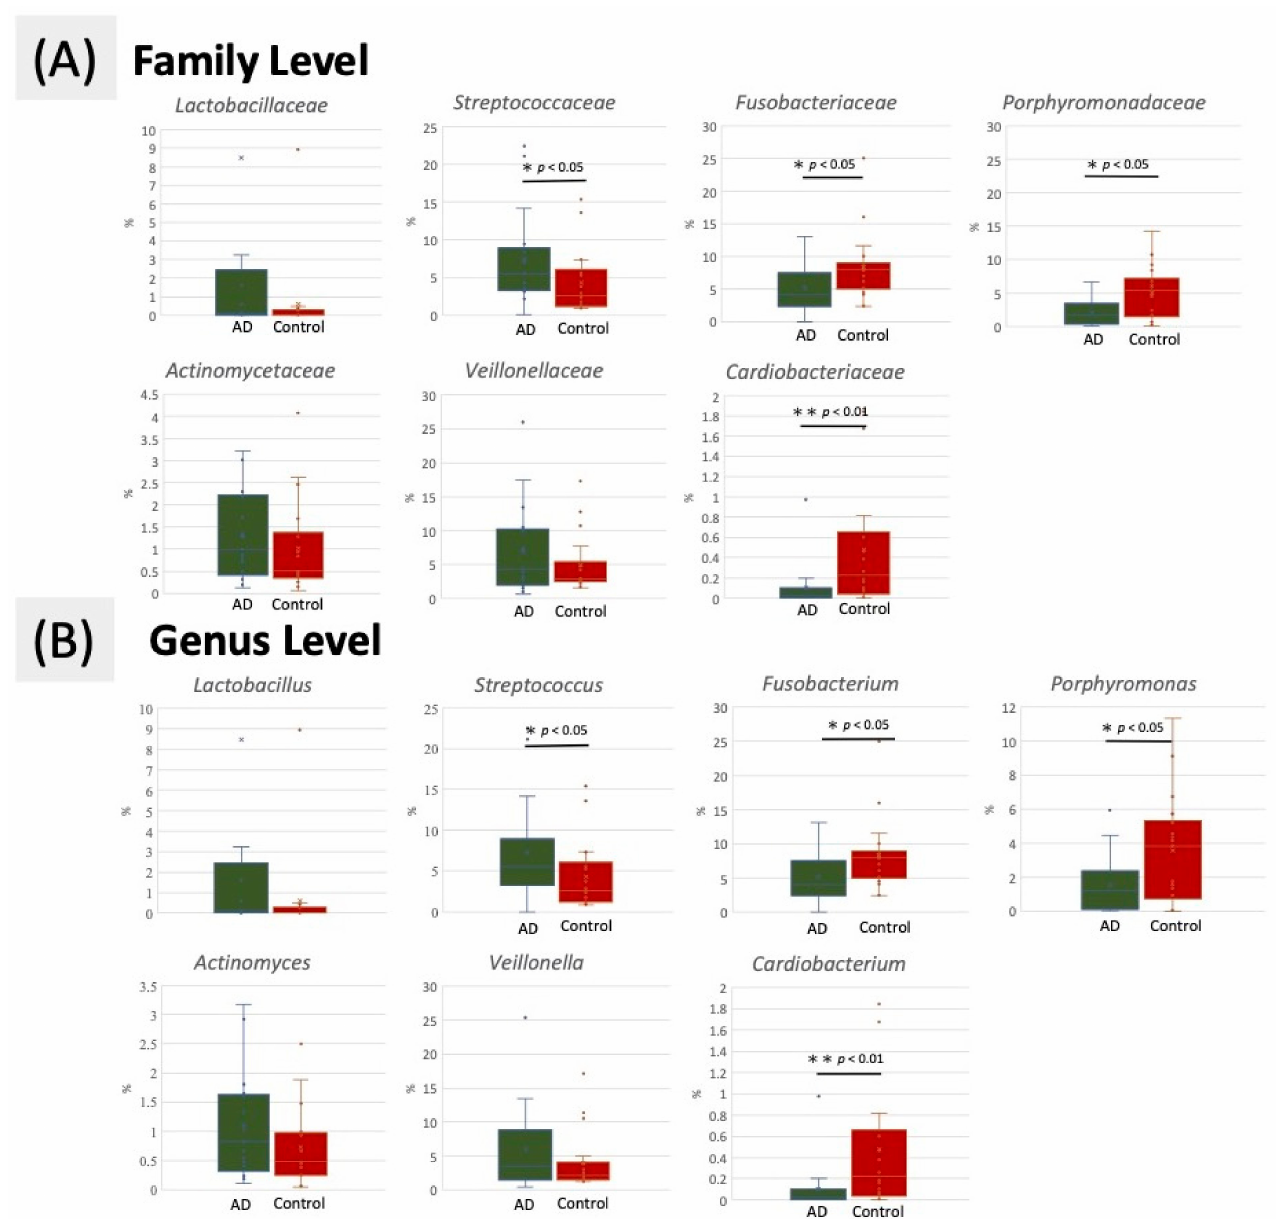
Figure 4. Comparison of relative abundance at the oral bacterial ( A ) family and ( B ) genus levels in the AD and control groups. * p < 0.05 and ** p < 0.01 respectively, using Mann–Whitney U